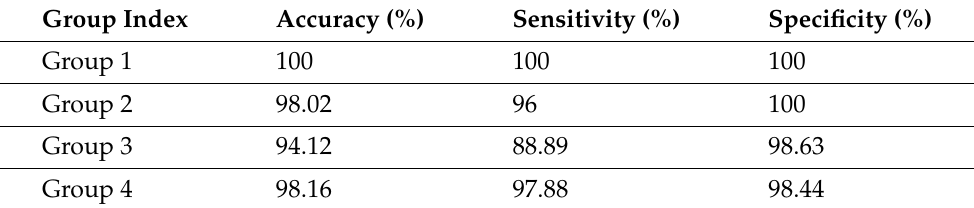
Table 11. The results of Experiment 5.